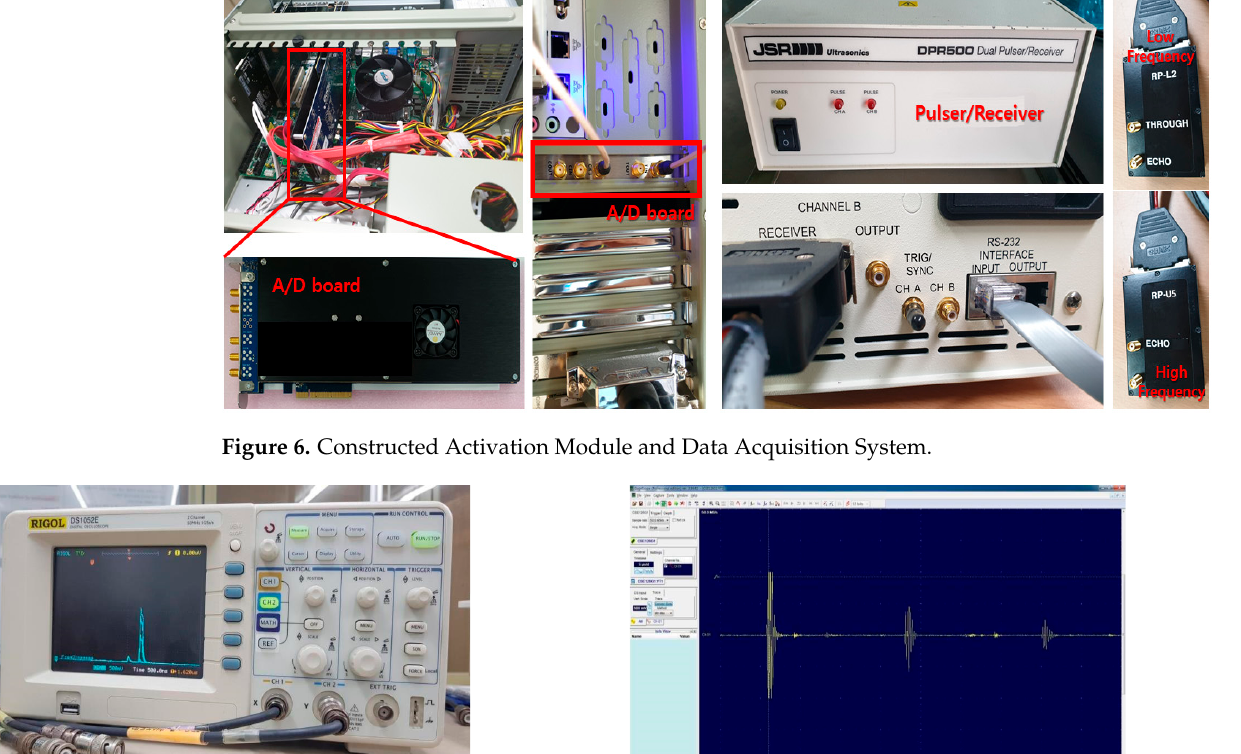
6 of 13 Figure 5. X-axis performance verification. 3.2. Activation Module and Data Acquisition System For the activation module, JSR Ultrasonics’ DPR 500 Dual Pulser/Receiver, which can simultaneously excite high-frequency (up to 500 MHz) and low-frequency bands, was in- stalled. DPR 500 can excite both low-frequency and high-frequency bands. In the case of the data acquisition system, the compatibility with the activation module is the most im- portant factor. The analog data of the high-resolution acoustic microscope must be con- verted into digital data, and Gage’s TB3-ENE126G10 A/D digitizer was selected to de- velop optimal software. It was selected because it can be installed in industrial computers built in PCI board format. Figure 6 shows the images of the constructed activation module and data acquisition system. The activation module was composed of the pulser/receiver